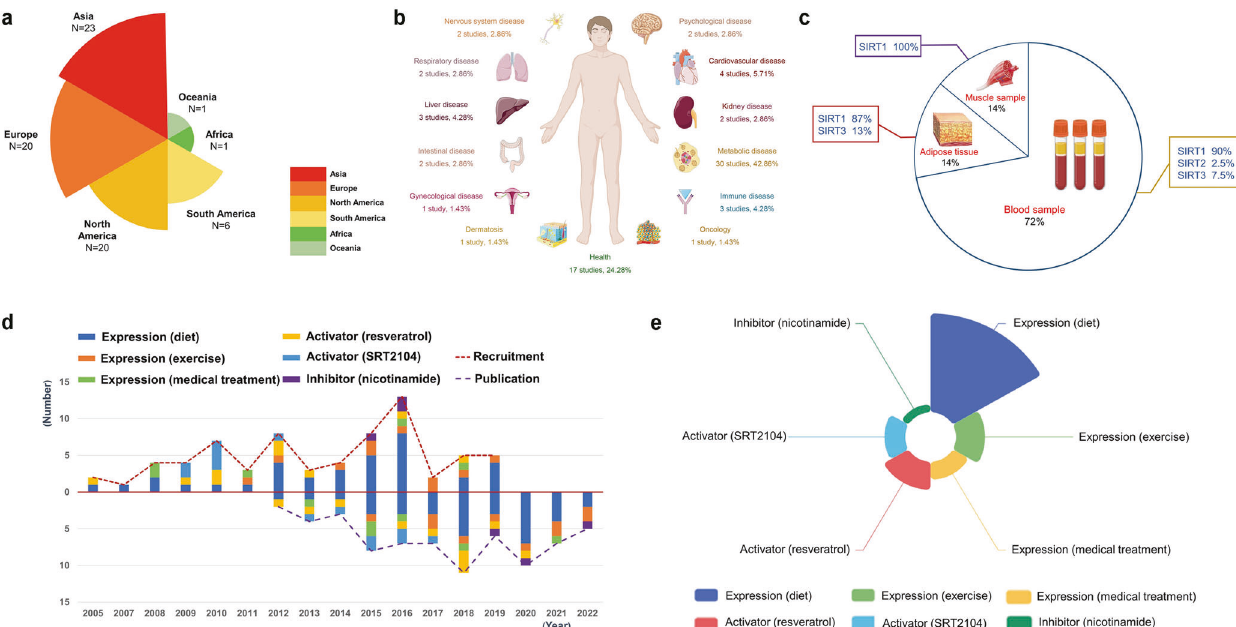
Fig. 18 Characteristics of included randomized controlled trials by ( a ) regions; ( b ) condition of subject; ( c ) examination of tissue and samples; ( d ) years of recruitment and publication; ( e )